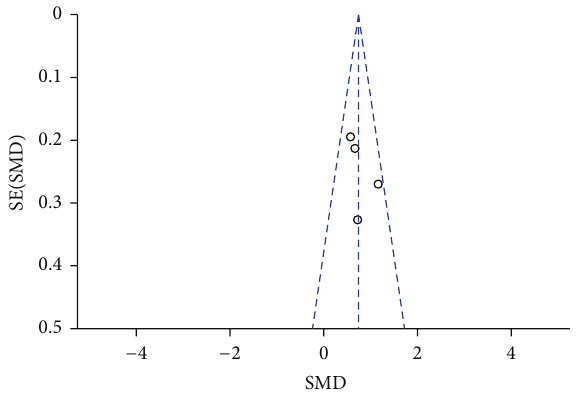
Figure 17: Funnel plot of CSF 𝛼 -syn oligomers levels in PD compared to